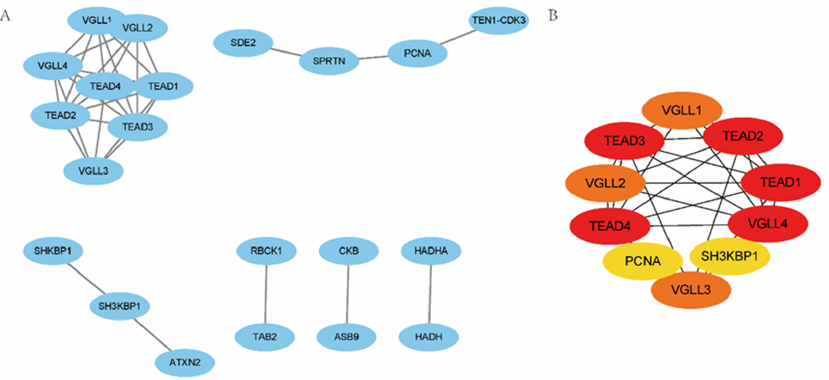
Figure 6. The PPI network of TRRDEGs and the prediction of the hub genes. ( A ) The PPI network of TRRDEGs. ( B ) Prediction of hub genes; a darker shade of red indicates a higher accuracy of prediction, ranging from yellow to red.